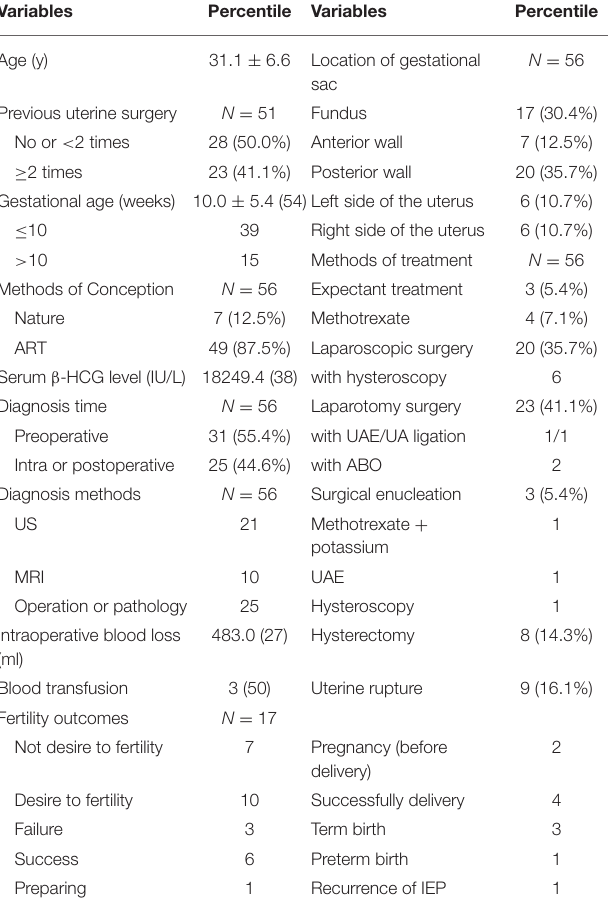
TABLE 3 | Clinical characteristics, treatment, and maternal outcomes of the database.